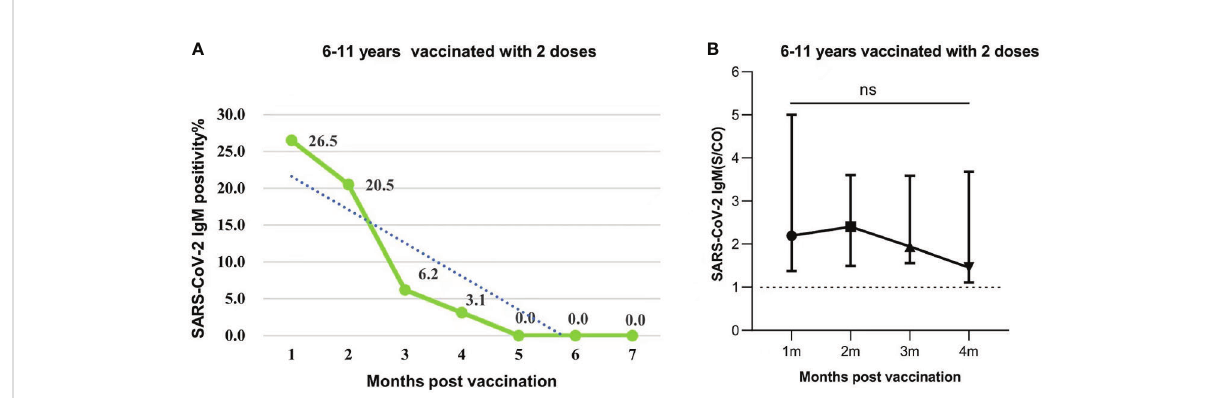
FIGURE 3 (A) SARS-CoV-2 IgM seropositivity in participants who were aged 6-11 years old and were vaccinated with 2 doses of vaccines after 1-7 months. Data were presented as percentage. (B) SARS-CoV-2 IgM antibody levels in participants aged 6-11 years injected with 2 doses post vaccination 1-4 months. Data were expressed as median (interquartile range), and analyzed using the Mann ‐ Whitney U test. The positive levels of SARS- CoV-2 IgM antibody showed no signi fi cant difference among different periods (months)(P=0.2051). The signs represent median values, and the lines represent interquartile ranges [1 month, 2.194 (IQR, 1.379-5.003); 2 months, 2.401 (IQR, 1.493-3.599); 3 months, 1.944 (IQR, 1.556-3.582); 4 months, 1.457 (IQR, 1.114-3.678)]. ns, not signi fi